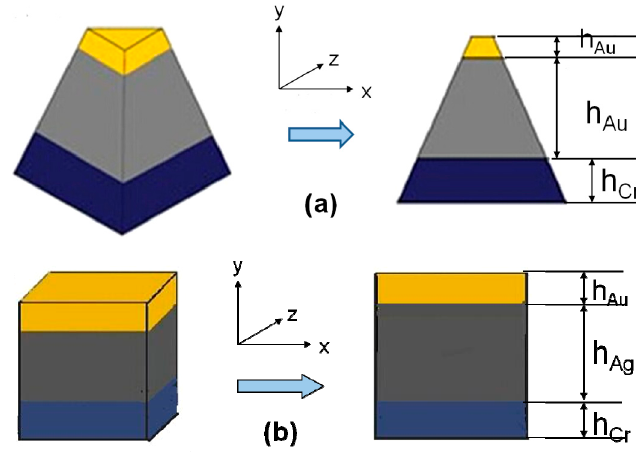
Figure 1. A monomer model of the hybrid Au–Ag nanoparticle arrays in 3D view and side cross-section view: ( a ) triangle; and ( b ) square.